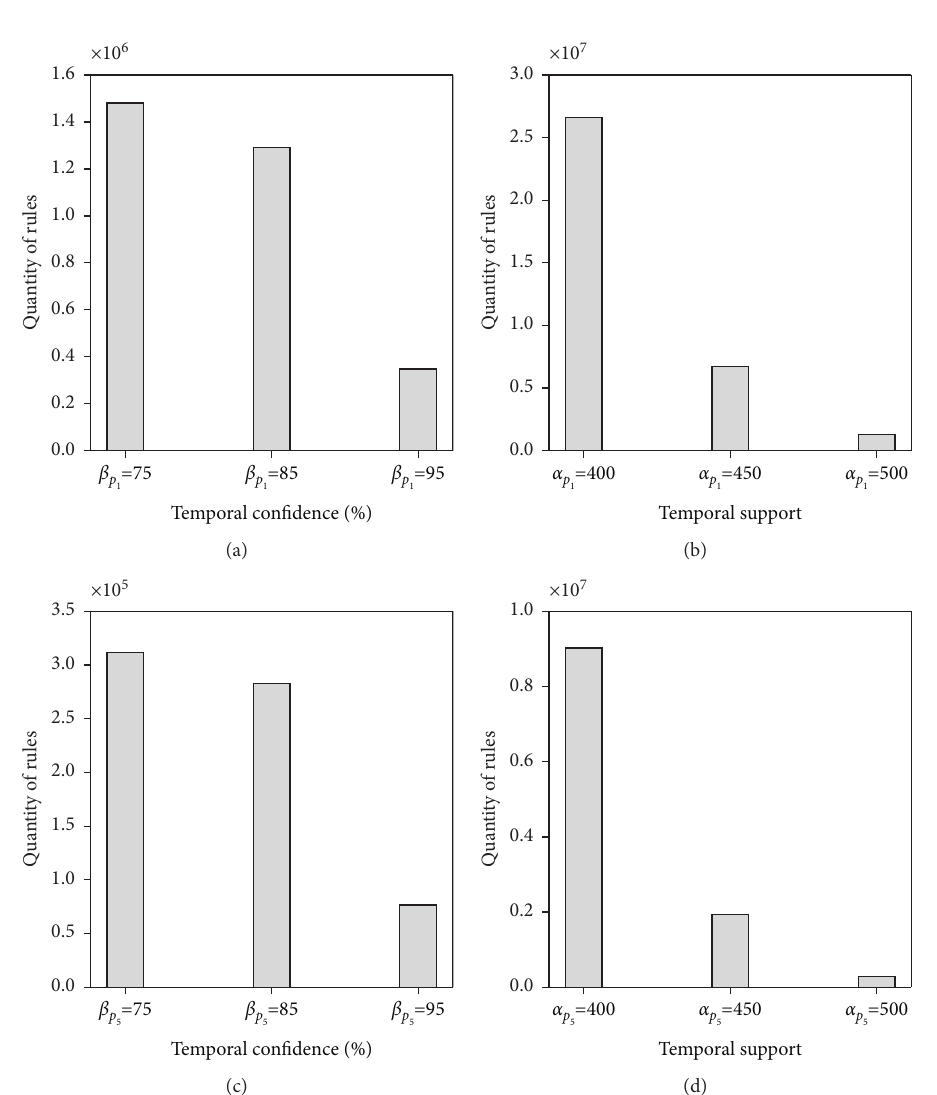
Figure 3: The quantity comparison of TARs based on the chess data set. (a) Q � p � 500. (d) Q � p 􏼈 􏼉 and α (c) Q � p p 5 5